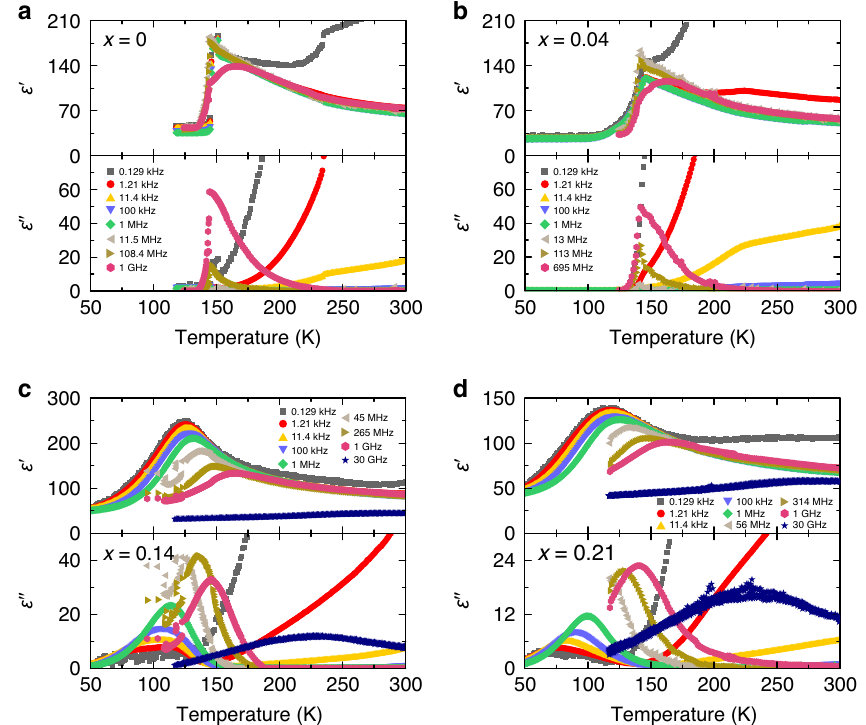
Fig. 3 Dielectric behavior of mixed MA 1 − x DMA x PbBr 3 perovskites. Temperature dependence of the real and imaginary parts of the complex dielectric permittivity at selected frequencies of a x = 0, b 0.04, c 0.14, and d 0.21 single crystal compounds measured on cooling.